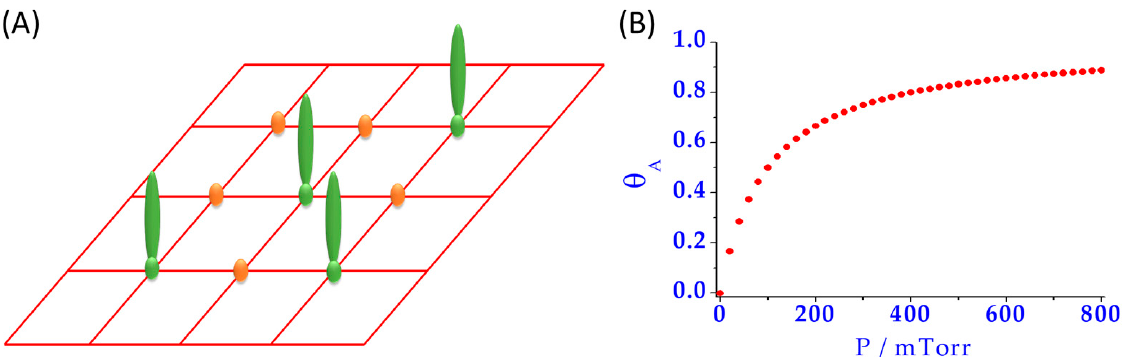
Figure 3. ( A ) Scheme of the equivalent free sites (orange) and occupied ones (green) assumed on the surface of an NM for the Langmuir model; ( B ) Example of a plot of the surface coverage ( θ A ) versus the partial pressure of the adsorbate (P), where the saturation point can be observed.